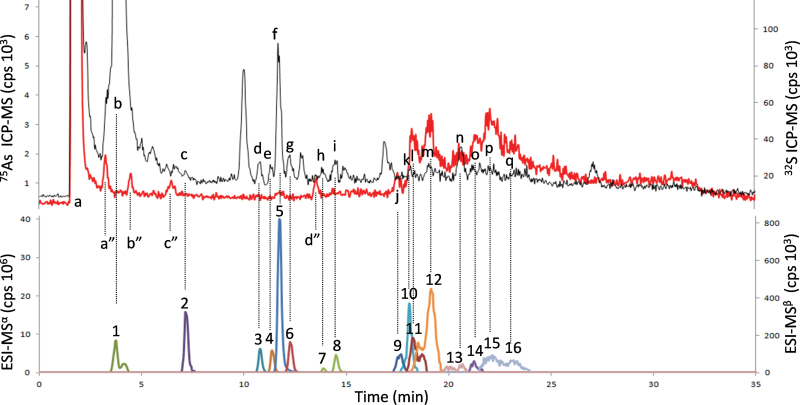
Determination by HPLC/HR-ICP-MS/LTQ Orbitrap ES-MS of PCs and PCs-As in roots of the Italica Carolina cultivar highly exposed to arsenate. HR-ICP-MS, 32S (black line); 75As (red line). LTQ Orbitrap ES-MS: 1α, GSH; 2β, GSSG; 3α, OH-Me-PC2; 4α, PC2 reduced; 5α, DesGly-PC2; 6α, PC2 auto-oxidized; 7–8α, Iso-PC2-Glu; 9β, OH-Me-PC3-As; 10β, PC3; 11β, PC3-As; 12β, DesGly-PC3-As; 13β, Iso-PC3-Glu; 14β, Iso-PC3-Glu-As; 15–16β, PC4-As. a, peaks of inorganic As and sulphate; j, l, m, o, p, q, peaks of PCs-As; a′′, b′′, c′′, d′′, As-complexes unidentified; b–q, peptides containing S or As and the corresponding LTQ Orbitrap ES-MS signals.